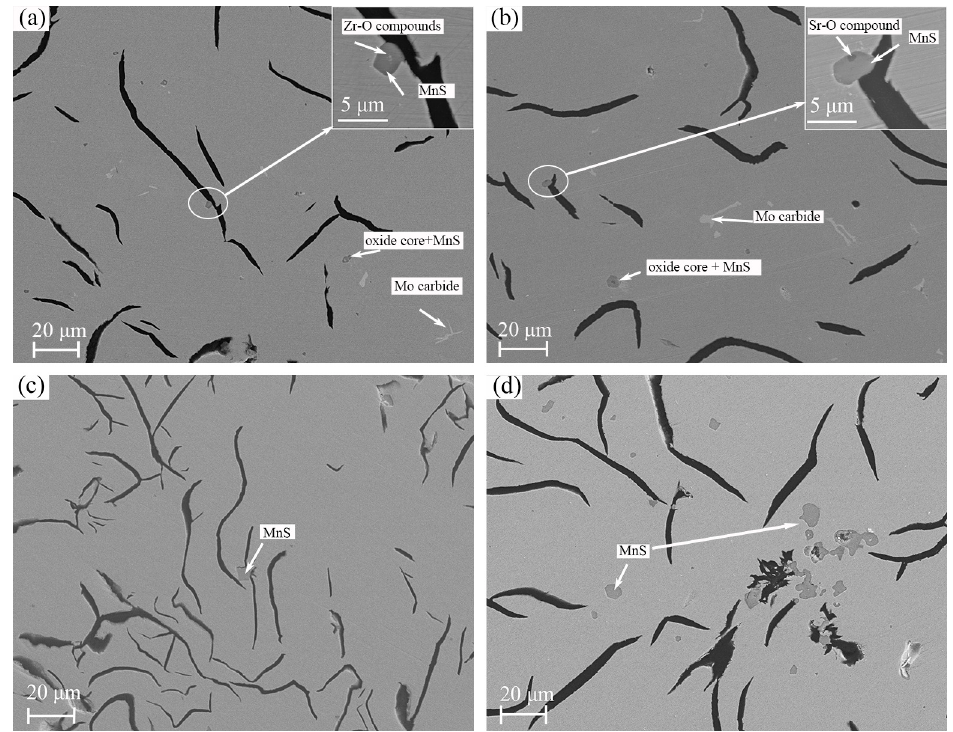
Figure 6. SEM images showing the morphology of MnS particles in S1 ‐ Z ( a ), S1 ‐ S ( b ), and S1 ‐ C ( c , d ). A statistical analysis was performed on the same samples to count the MnS particles. The average value of 8 SEM images at a random location of the polished surface of samples was recorded as the count. The results are provided in Figure 7. Remarkable differences were observed in the count of MnS particles depending on the selected inoculant. The Zr-FeSi inoculated samples have the largest number of MnS particles while the least number was found in SiC inoculated irons.